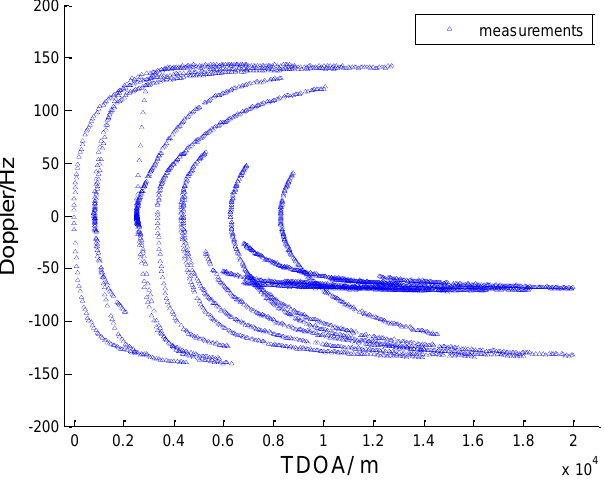
Figure 3. Measurements for three targets without clutter,